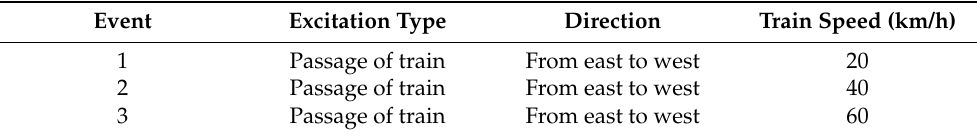
Table 2. Train passages during dynamic load testing.